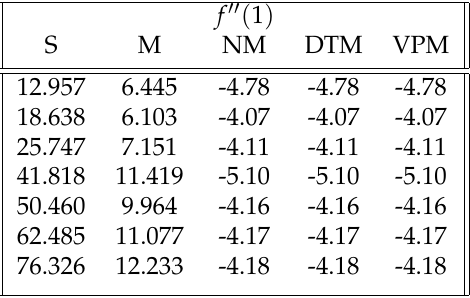
Table 4. Comparison of results of skin friction for large separation number under the influence of magnetic field